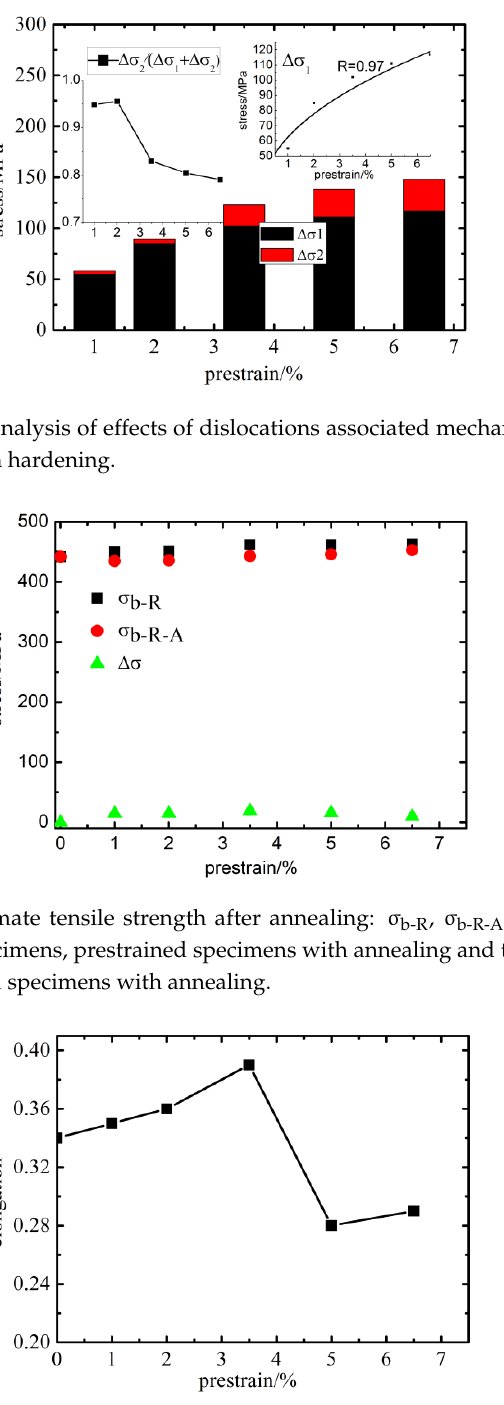
Figure 13. Elongation of prestrained specimens with annealing.